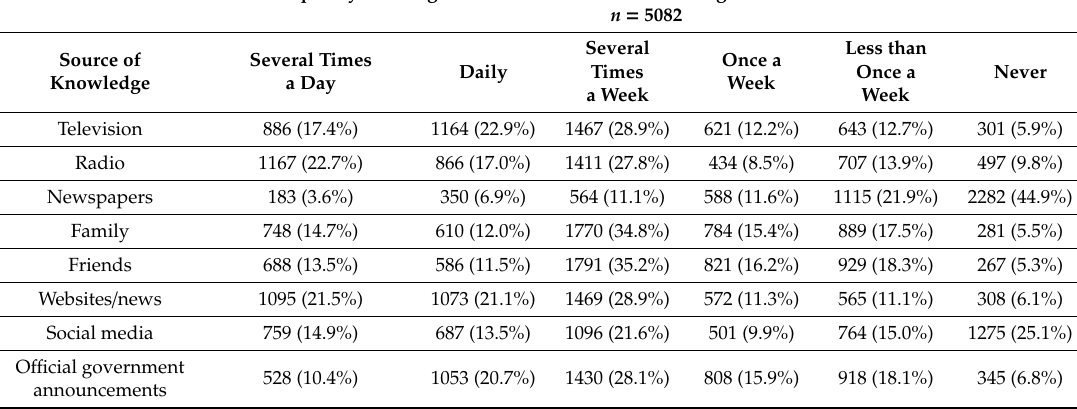
Table 1. Source of knowledge on SARS-CoV-2 infection prevention ( n =